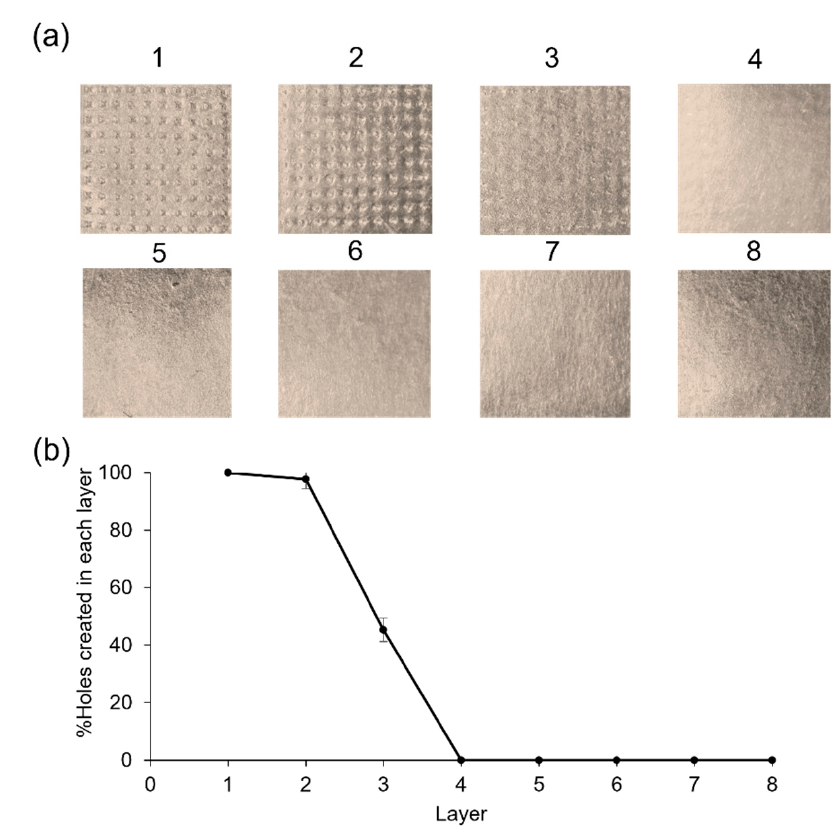
Figure 5. ( a ) Skin insertion test of hydrogel-forming MNs on ( b ) model skin (PF) layers.